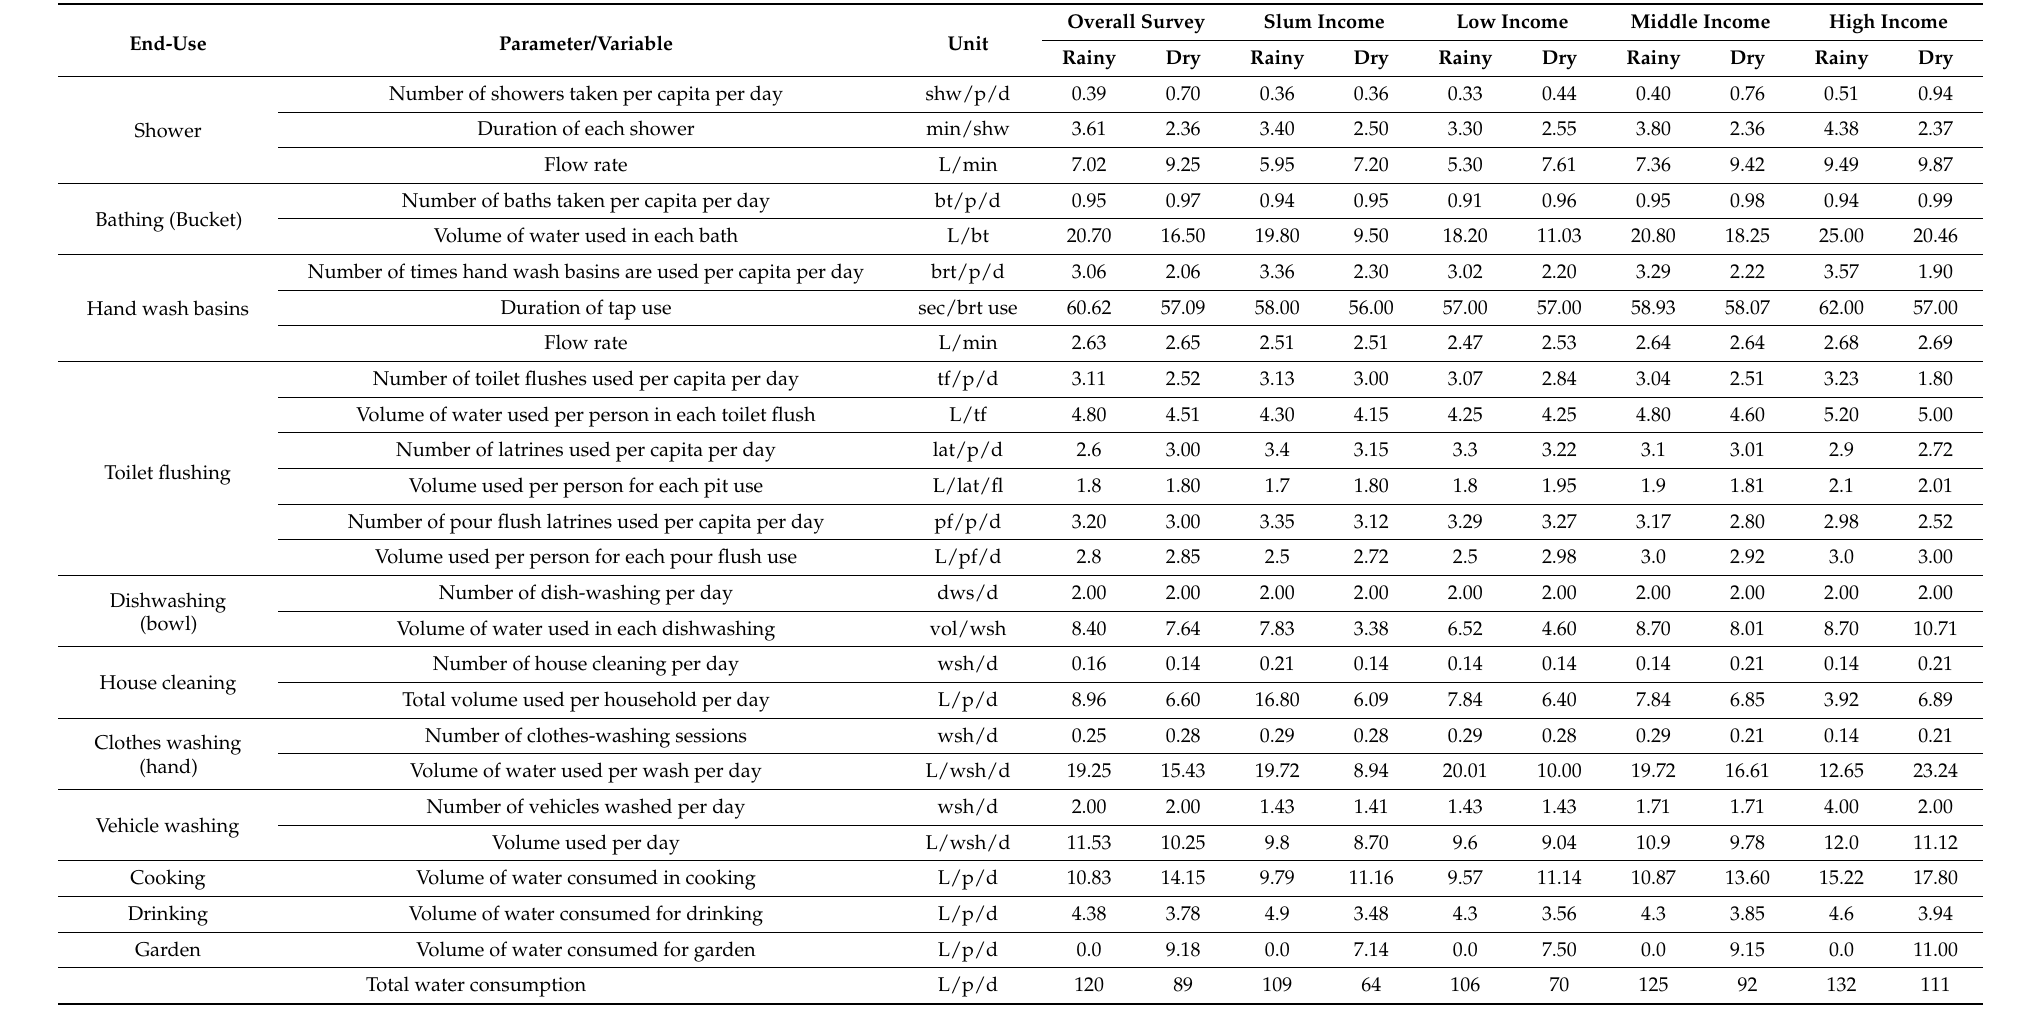
Table 7. Statistical variability of mean values of water end-uses